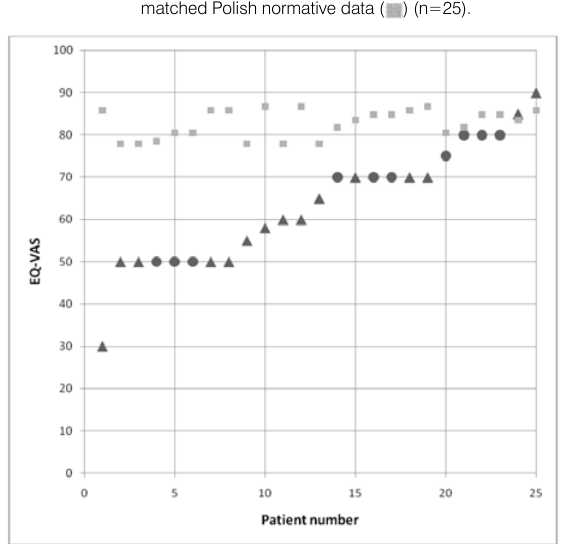
Table 1. Demographic characteristics of Polish patients with Fabry’s disease included in the study.